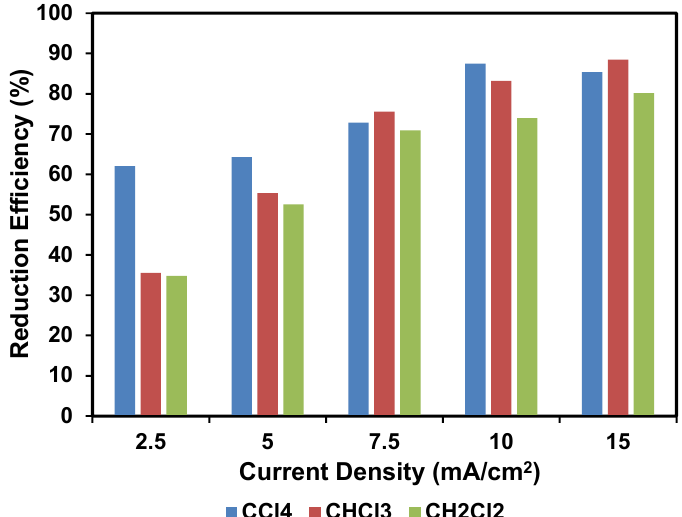
Figure 2. Current density variation on the reduction efficiency of the organochlorides (electrolysis conditions: time 30 min, solution pH 6.4, 5 mM concentrations of CCl 4 , CHCl 3 , and CH 2 Cl 2 ).